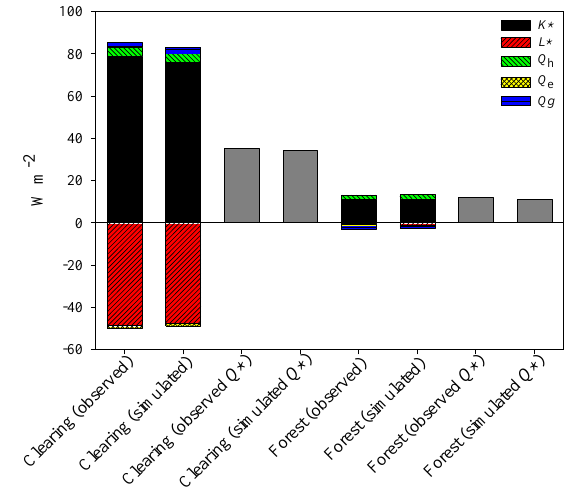
Figure 7. Fig. 7. Observed and simulated net energy terms and total energy to snow ( Q * = d U /d t + Q m ) at pine forest and clearing sites (note that due to no observations of simulated sensible ( Q h ) and latent ( Q e ) heat fluxes, observations are assigned the same value as simu-